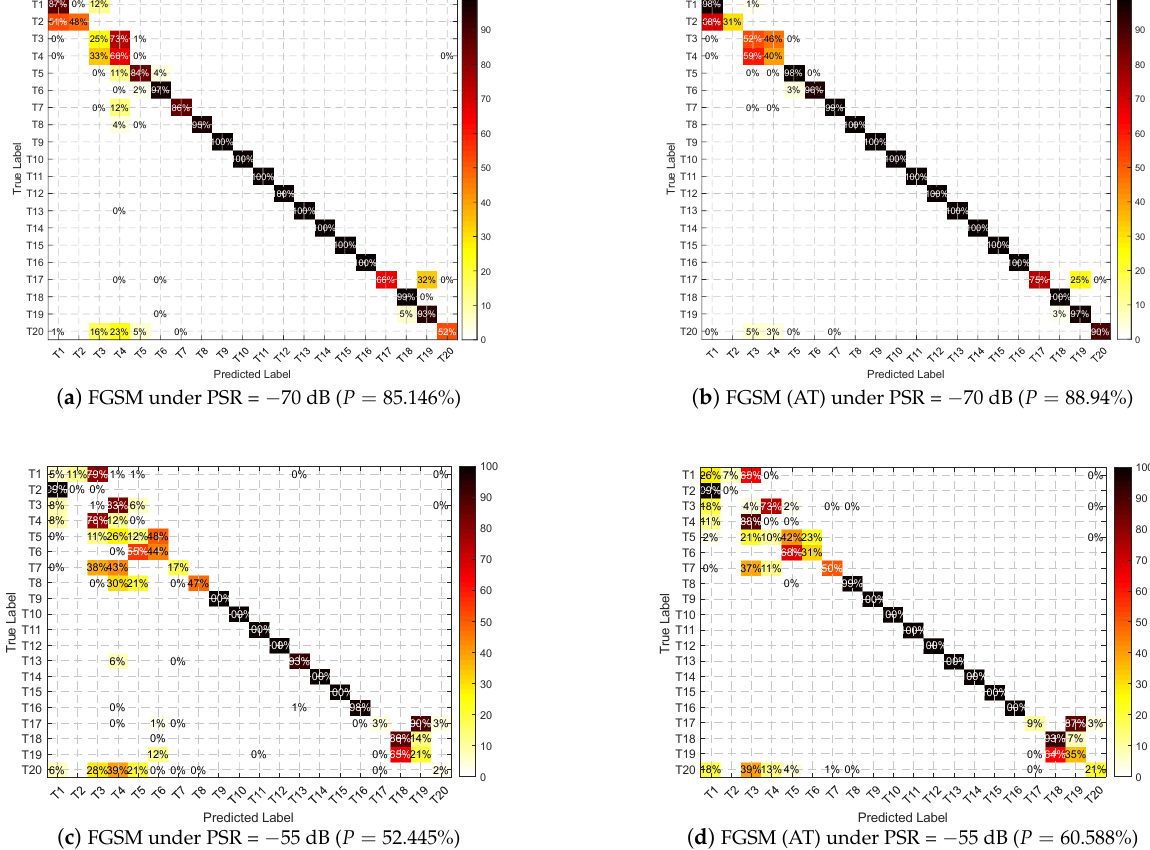
Figure 19. Recognition effect of the system with and without AT under FGSM attack when SNR = 35 dB for Dataset